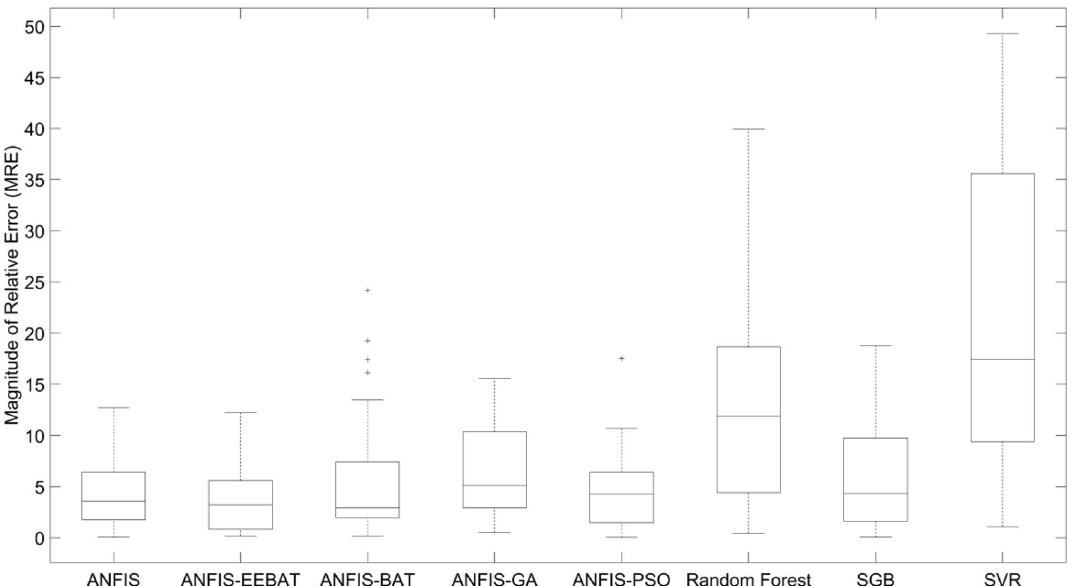
Figure 7. Box Plot of ANFIS-EEBAT with other models on ZKmS dataset. It can be inferred from the plot that ANFIS-EEBAT has the lowest value of the